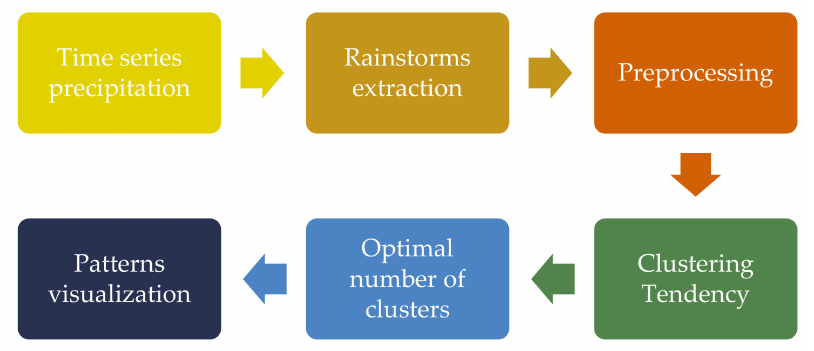
Figure 1. Flowchart of the applied